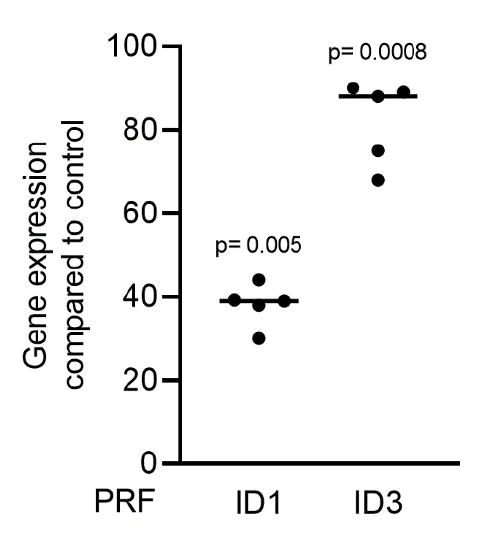
Figure 2. RT-PCR and immunoassays triggered by solid PRF lysates confirmed the presence of BMP2. Gingival fibroblasts were stimulated with 30% soluble PRF lysates. ( A ) Reverse transcription PCR analysis for BMP2 is indicated; ( B ) The levels of BMP2 in the supernatant of the fibroblasts are presented as ng/mL. n = 4. Statistical analysis was performed with a two-tailed t -test. p values are reported comparing the PRF group with the untreated control. Here, and throughout this study, significance was set at p < 0.05. ”wo” indicates without and represents unstimulated cells.